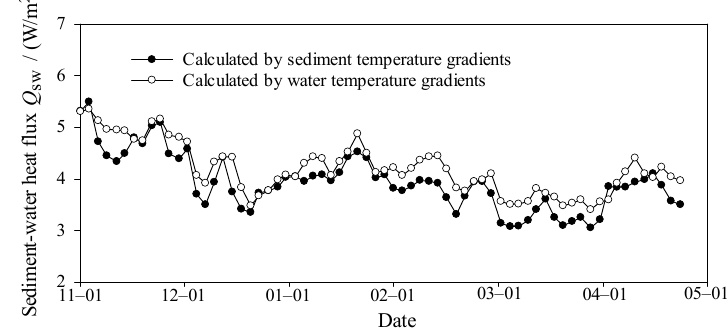
Figure 8. Seasonal variations in sediment–water heat flux over the ice-cover duration.